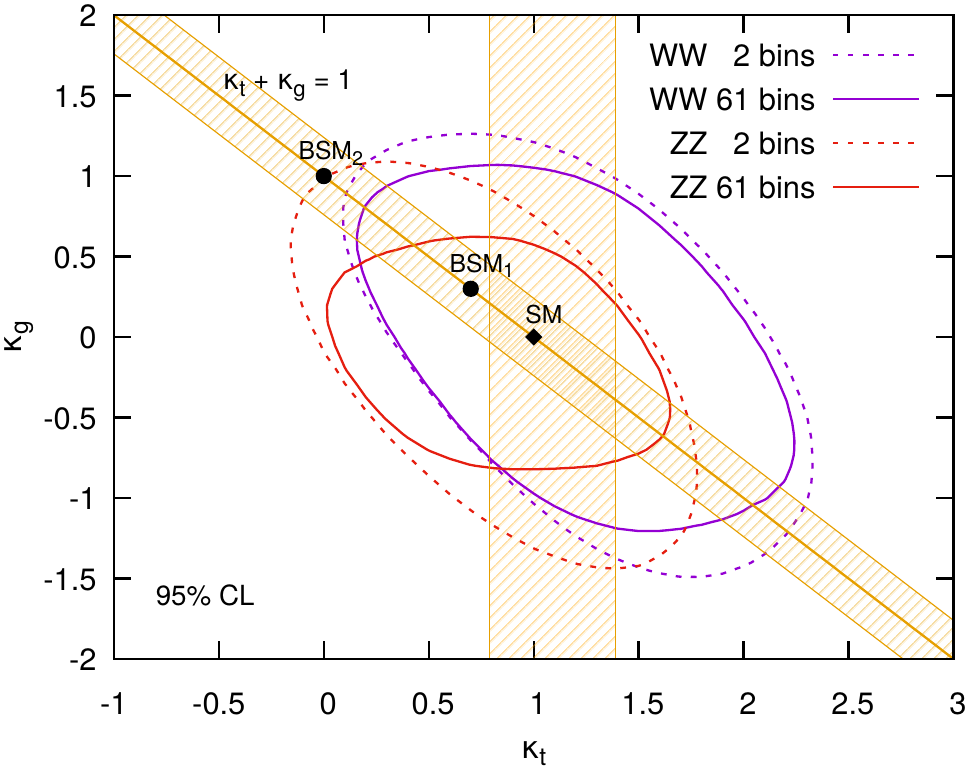
Figure 12 . Exclusion contours at 95% level for WW and ZZ production. See the main text for